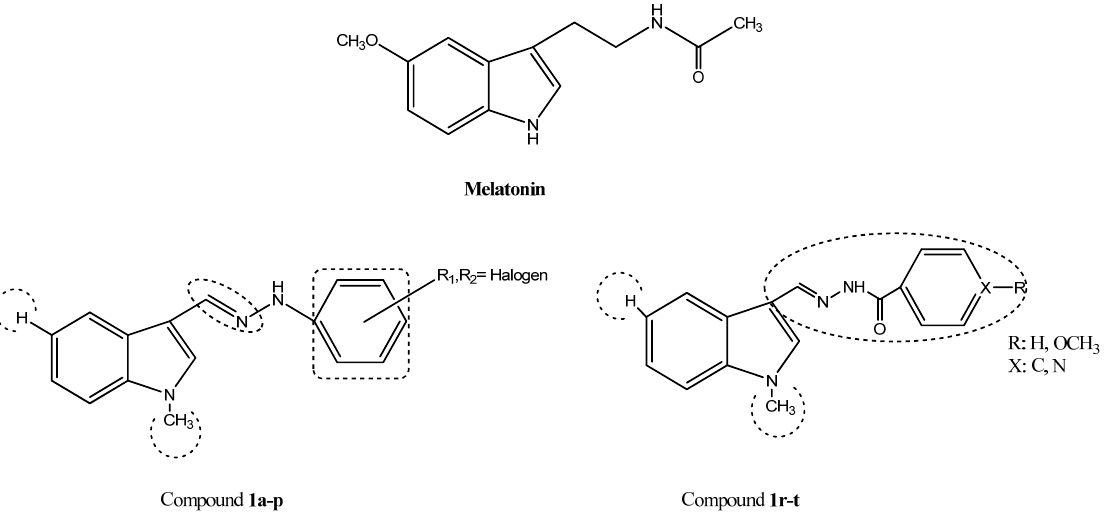
Figure 1. Parts of the MLT molecule modified to develop new indole-based MLT analogue